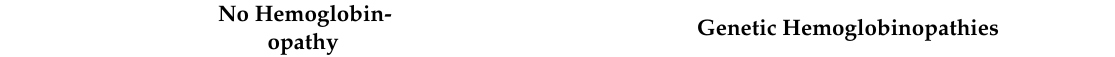
Table 2. Distributions of complete blood count (CBC) biomarkers among women, by hemoglobinopathy classification.